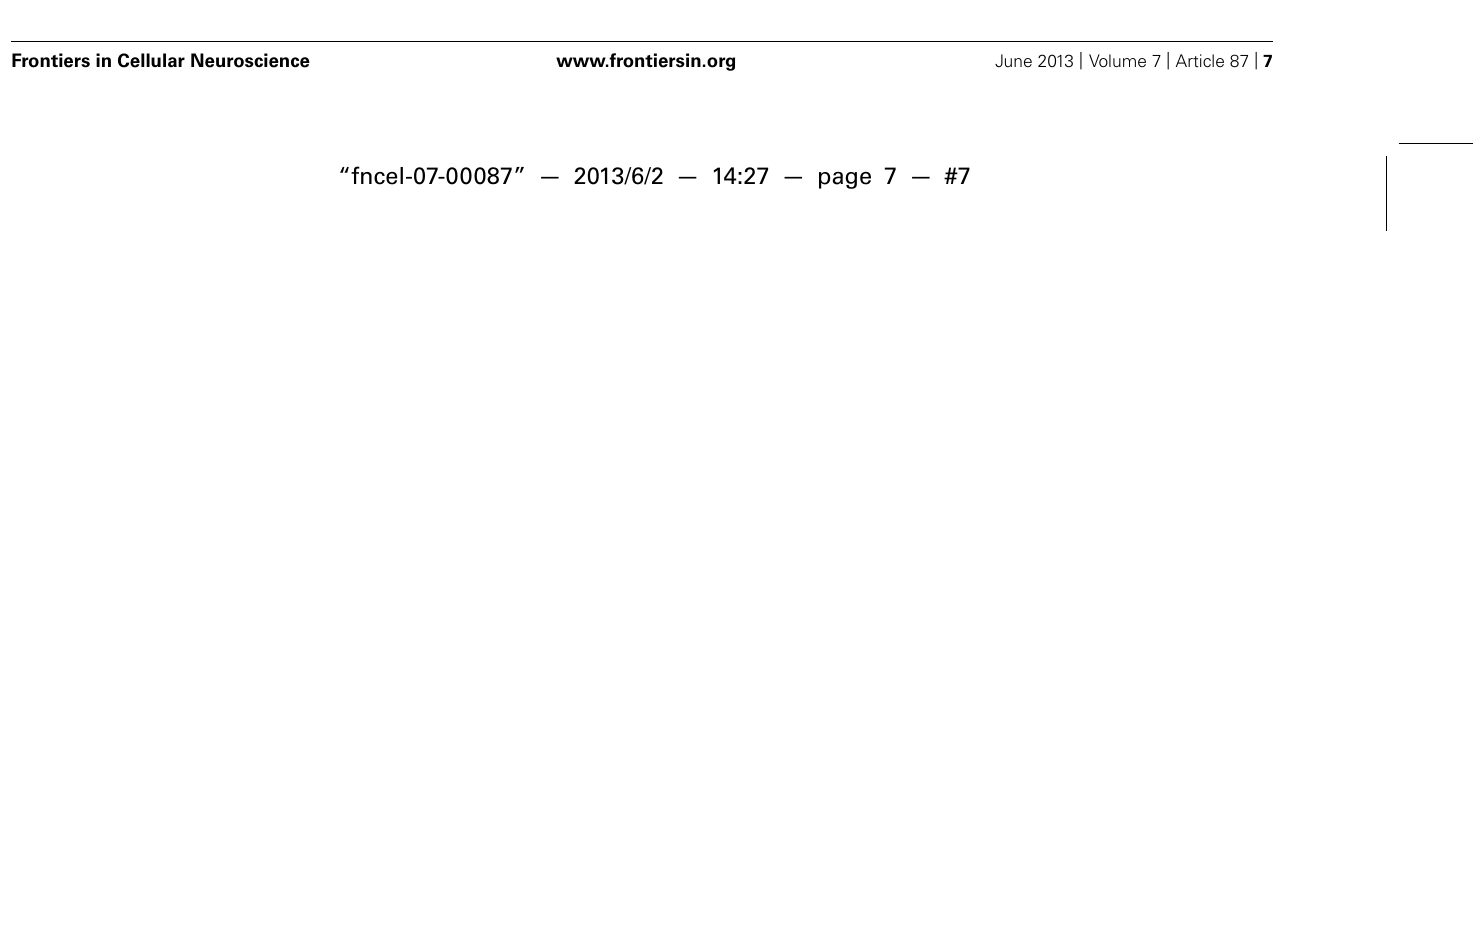
FIGURE 4 | Model of mechanism of repression of neurogenic bHLH transcription factors by BMPs. (A) In differentiating neurogenic precursors, bHLH transcription factors hetero-dimerizes with E proteins, which bind to E boxes and promote expression of neuronal genes. (B) Activation of the BMP signaling pathway leads to increased levels of Id and Hes proteins. Id and Hes